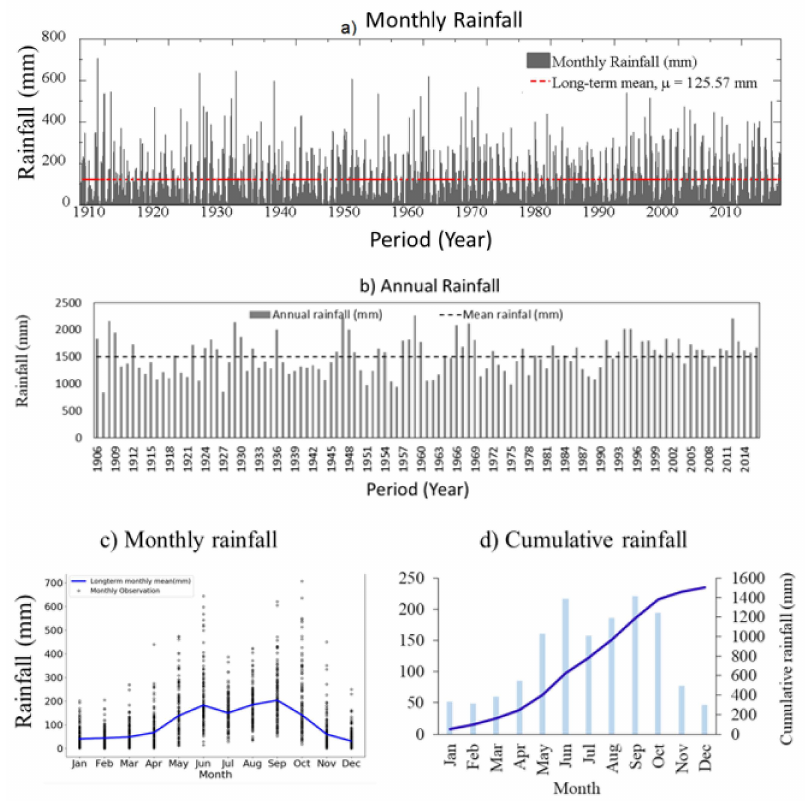
Figure 2. ( a ) Total monthly rainfall distribution for southern Florida from 1906 to 2016, ( b ) total annual rainfall and its deviation from the long-term normal rainfall, ( c ) observations by month, and ( d ) mean monthly and cumulative rainfall histogram.